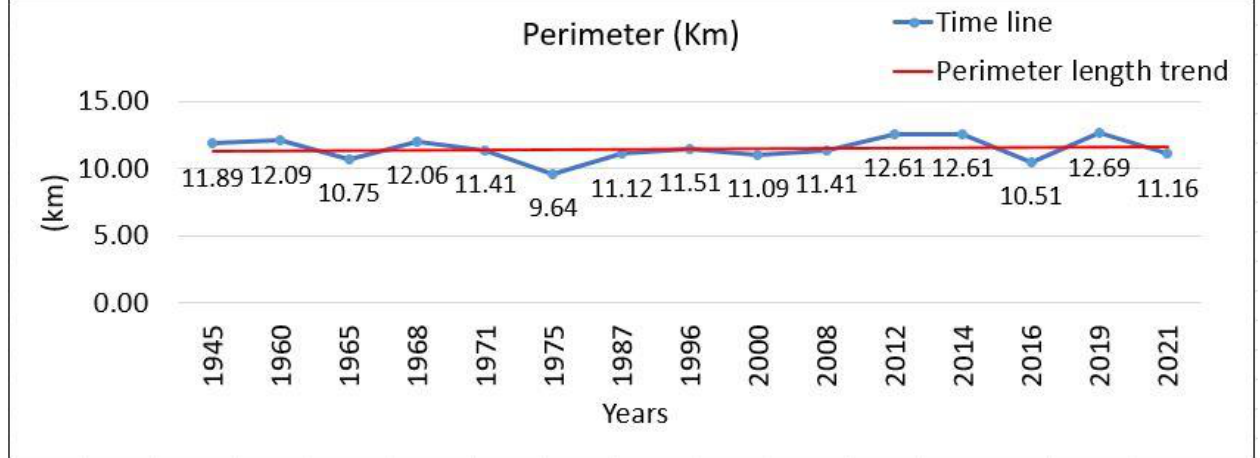
Figure 8. Water surface area fluctuations during the study period.